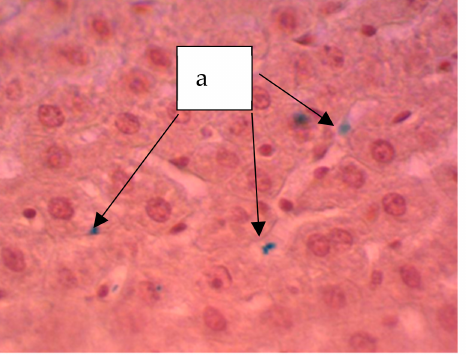
Figure 9. Liver of a rat. Staining according to the Perls method. The particles stained blue can be seen (a). ×